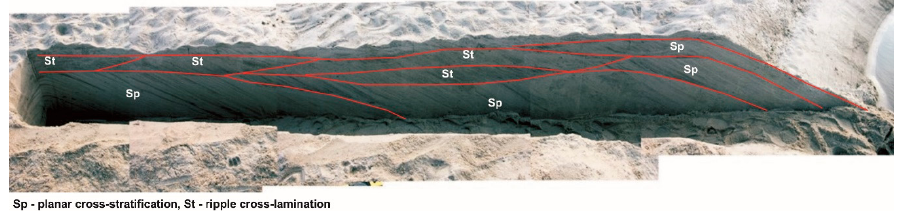
Figure 11. Sedimentary structures in the channel bar head—20 November 2012.